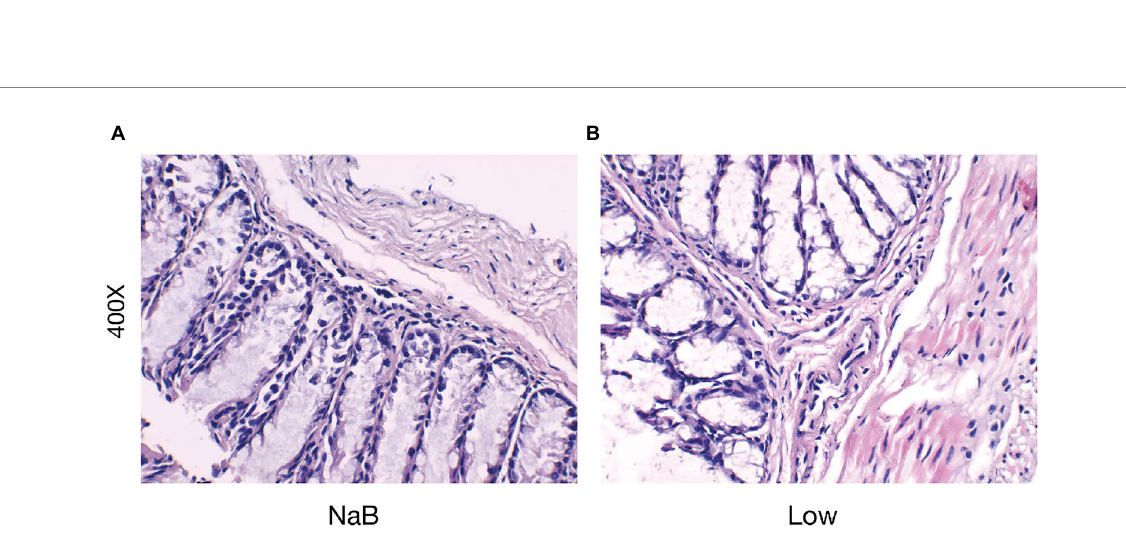
FIGURE 13 Butyrate reduced the severity of intestinal barrier inflammation and injury. H&E staining of colonic mucosa (400×) (A) the NaB group; (B) the Low